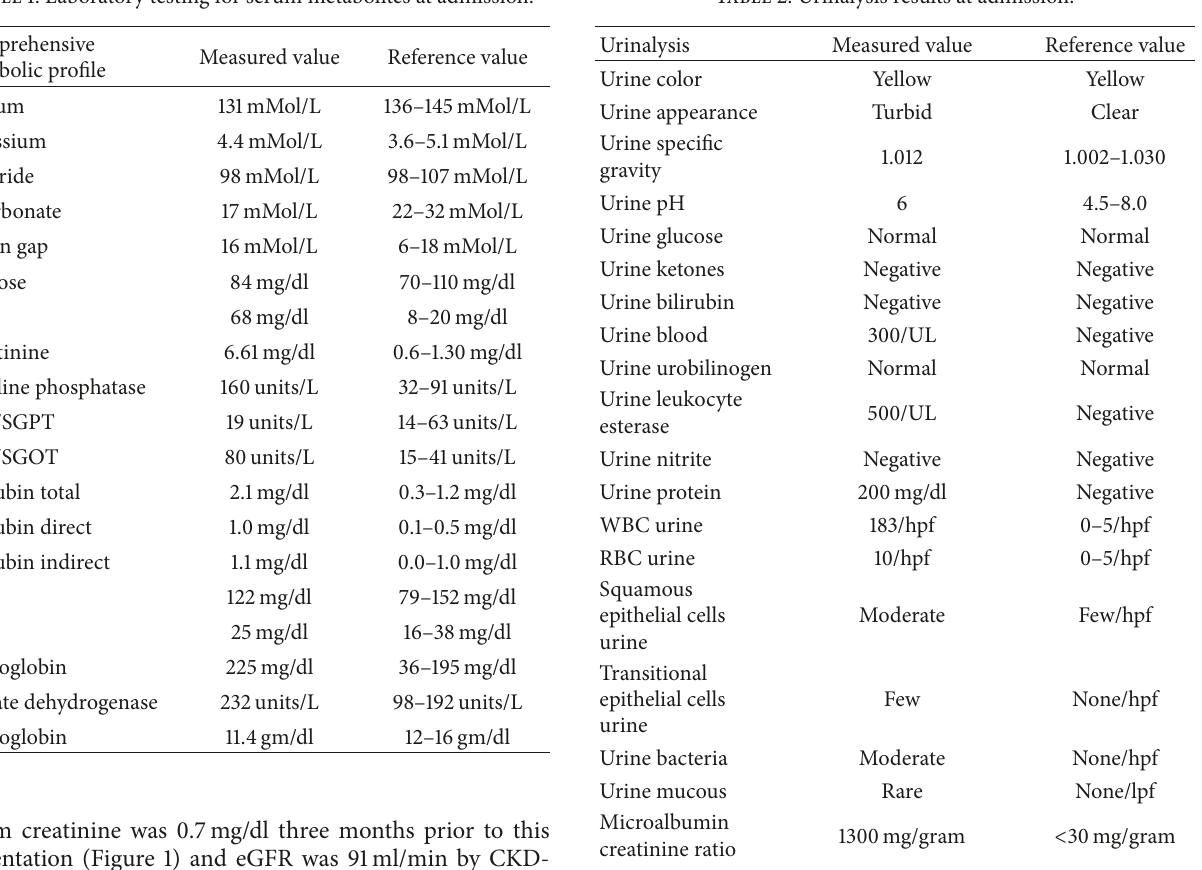
Table 1: Laboratory testing for serum metabolites at admission. Table 2: Urinalysis results at